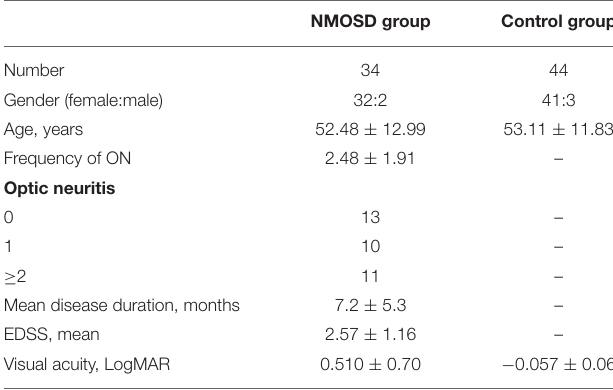
TABLE 1 | Demographics and clinical variables.